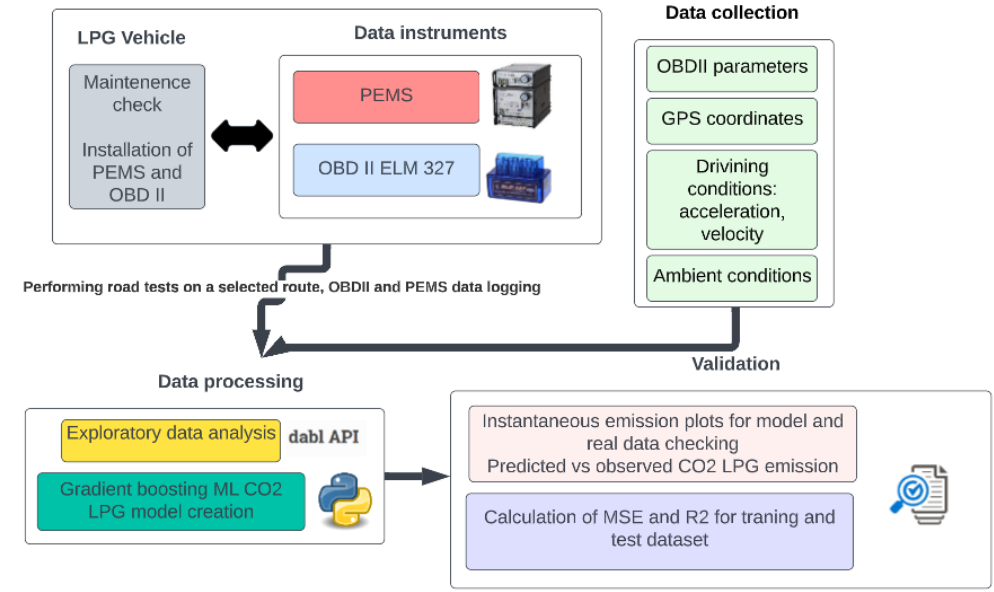
Figure 1. Basic logic and scheme of the performed research.